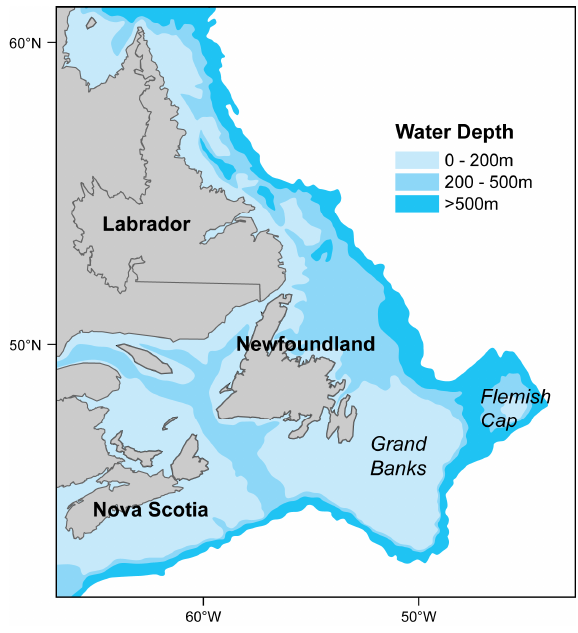
Figure 8. Atlantic Margin shelf water